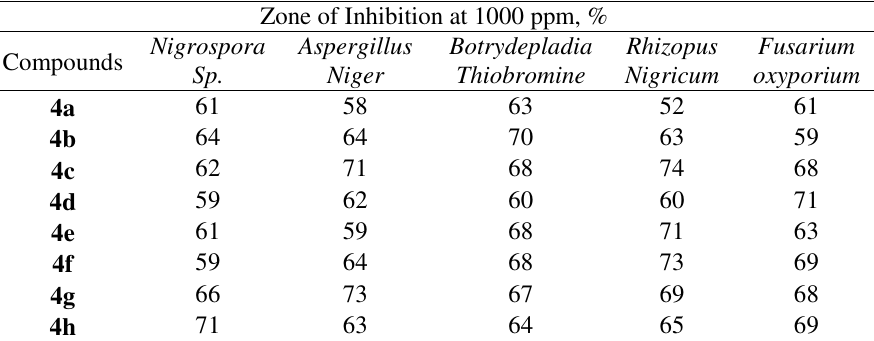
Table 7. Antifungal activity of compounds ( 4a-h